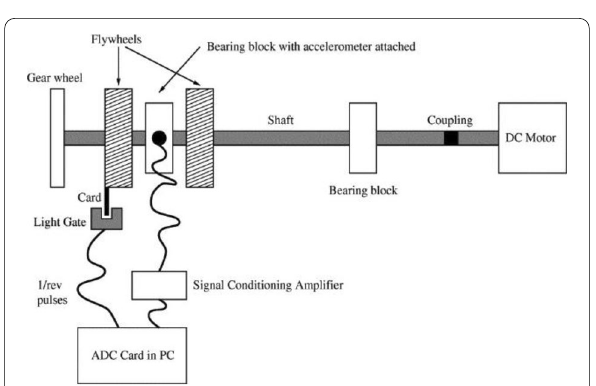
Figure 7 Test rig used to obtain the first vibration data of